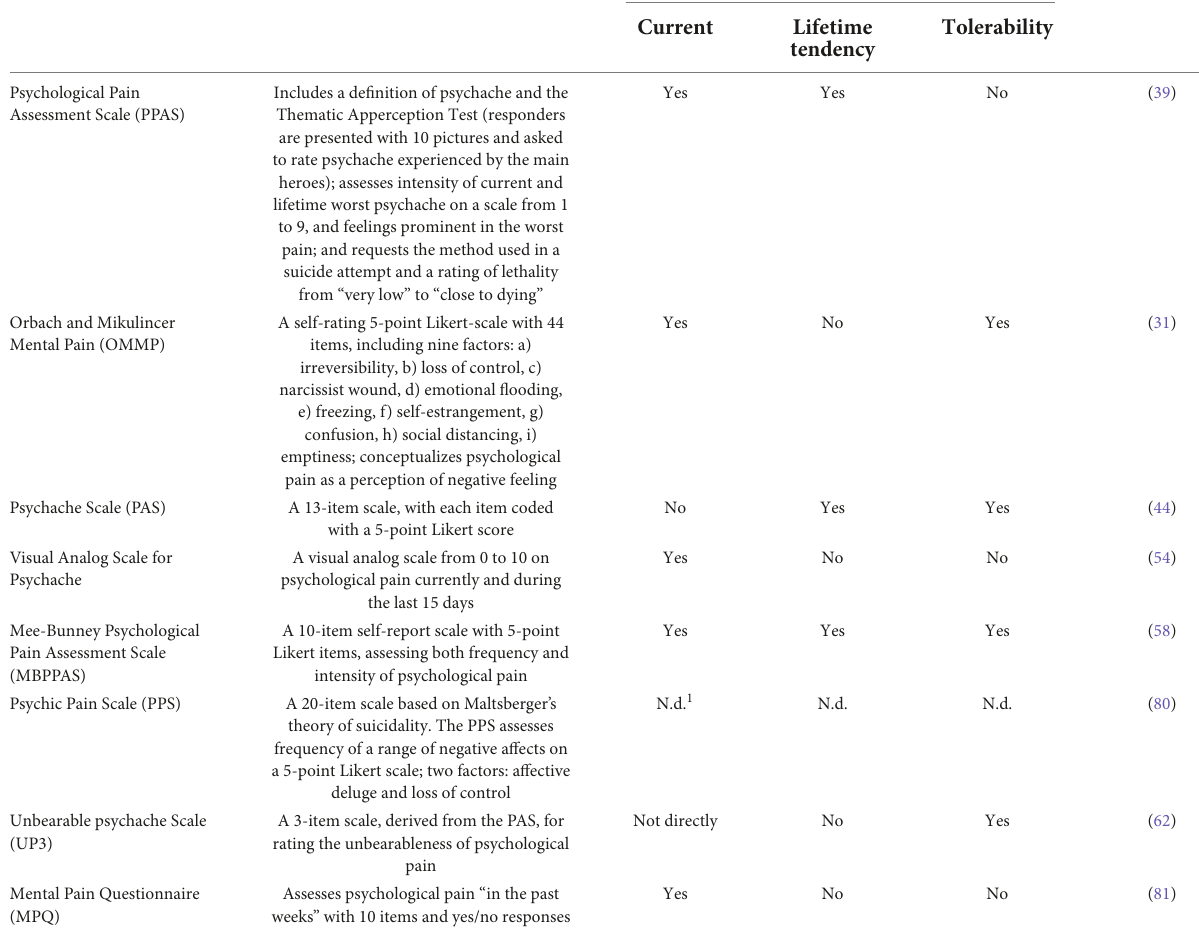
TABLE 1 Assessment tools developed to measure psychological